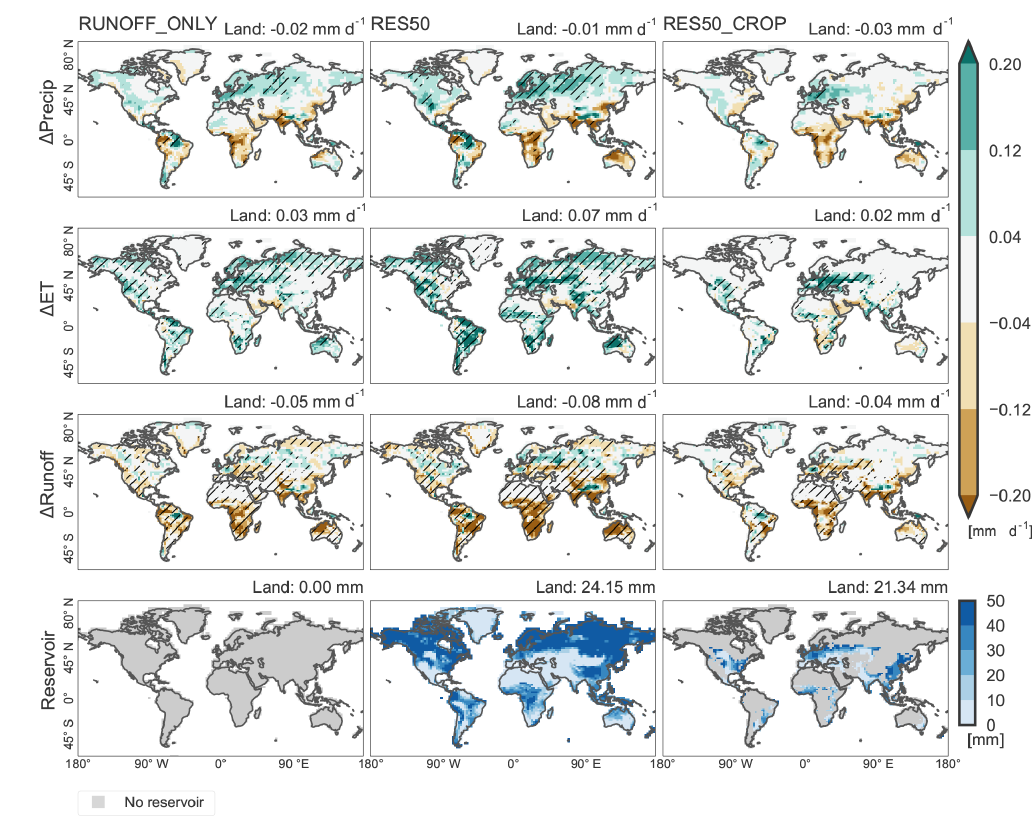
Figure 3. Difference between EXP and REF for precipitation (Precip), evapotranspiration (ET), and runoff. The fourth row shows the mean reservoir state. Hatching in the first three rows indicates grid cells with significant changes (Wilcoxon–Mann–Whitney U test with a global p value of 5%). Note that runoff values for the experiments can become zero, which leads to significant runoff changes in some regions with very small absolute